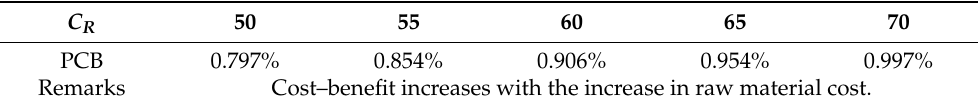
Table 9. Sensitivity of raw material cost to cost–benefit. The static input values of the parameters